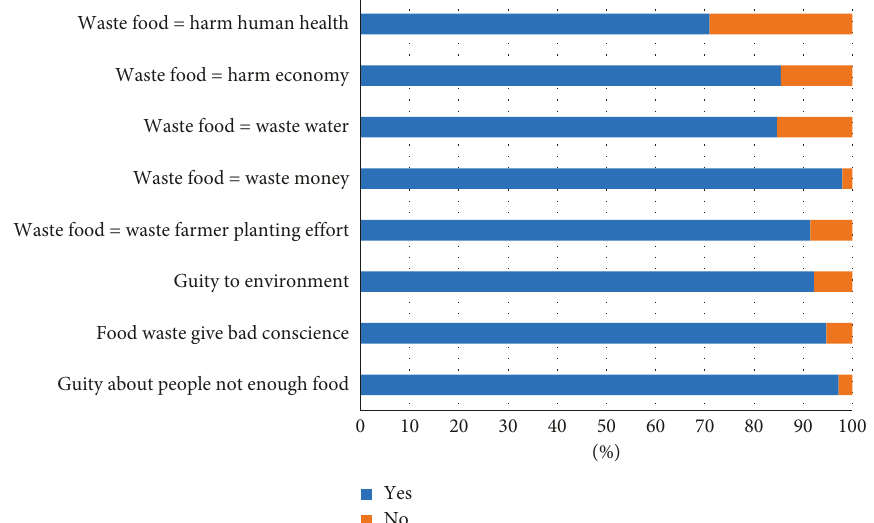
Figure 8: Perception of food waste.